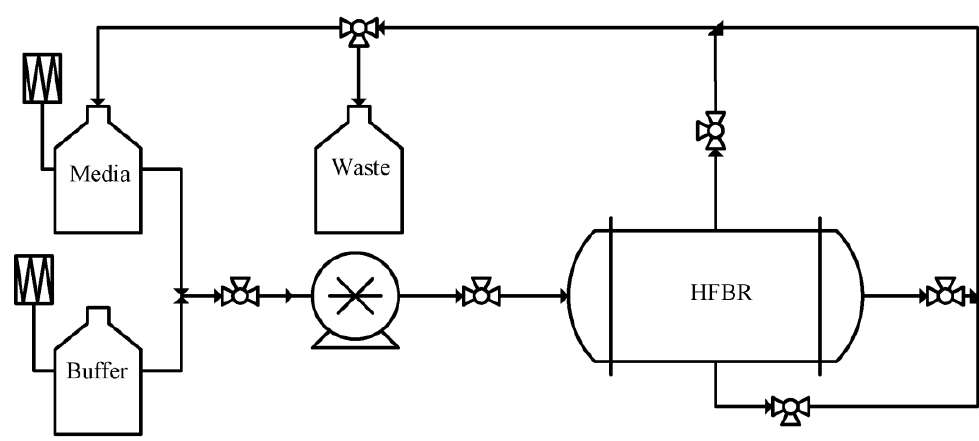
Figure 4. Block flow diagram of a typical hollow fibre bioreactor configuration consisting of a positive displacement pump, hollow fibre cartridge, media, buffer, and waste reservoirs.